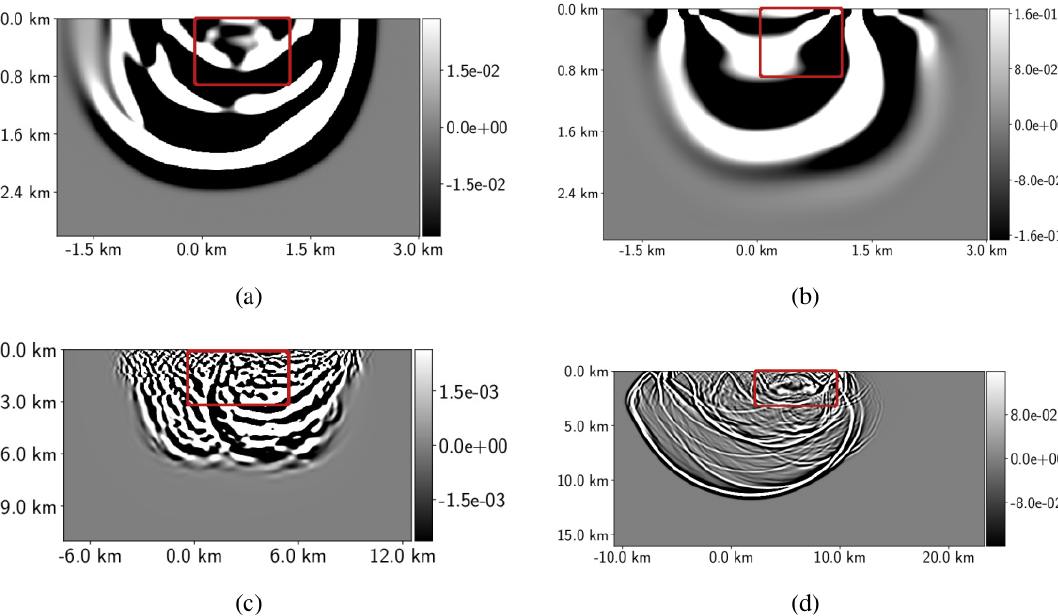
Figure 6. Reference solutions of the forward wave equation ( u ). (a) Circle velocity model at t = 1s. (b) Horizontal layers velocity model at t = 1s. (c) Part of the Marmousi velocity model at t = 6 . 4s. (d) 2D SEG/EAGE salt velocity model at t = 6 . 4s. The regions inside the red square are the physical domains, with the red lines indicating the boundaries ( ∂(cid:127) 0 ), and the regions outside are the extended